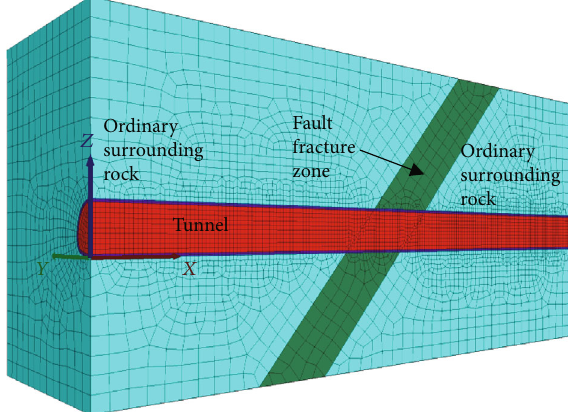
Figure 7: Longitudinal section of 3D numerical